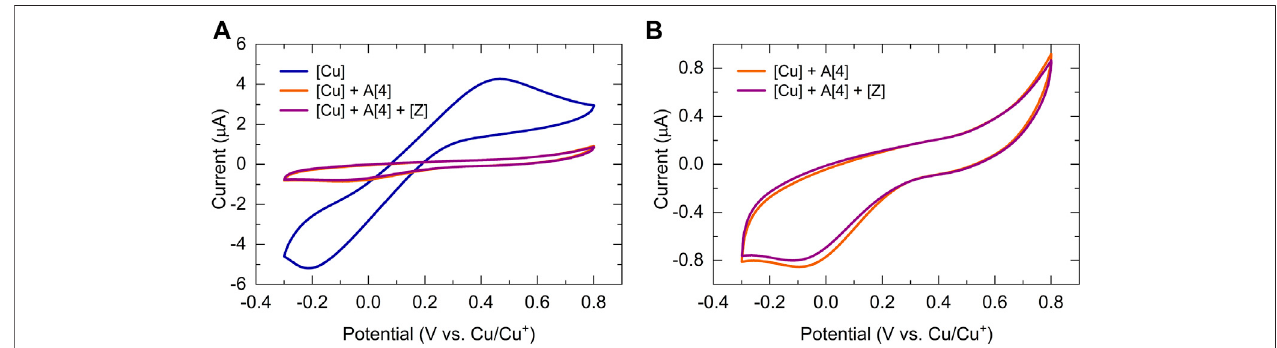
FIGURE 5 | Cyclic voltammogram of bismuth(III) acetylides in the presence of the copper(I) tri fl uoromethanesulfonate toluene complex at 25 ° C in dry DMSO recorded at 100 mV/sec. Voltammograms of the (A) copper(I) tri fl uoromethanesulfonate catalyst (blue), after the addition of acetylide (orange), and after stepwise addition of acetylide and azide (purple); (B) copper(I) tri fl uoromethanesulfonate catalyst after the addition of acetylide (orange), and after stepwise addition of acetylide and azide (purple). Conditions: 3-electrode cell with glassy carbon as the working electrode, copper foils as counter, and reference